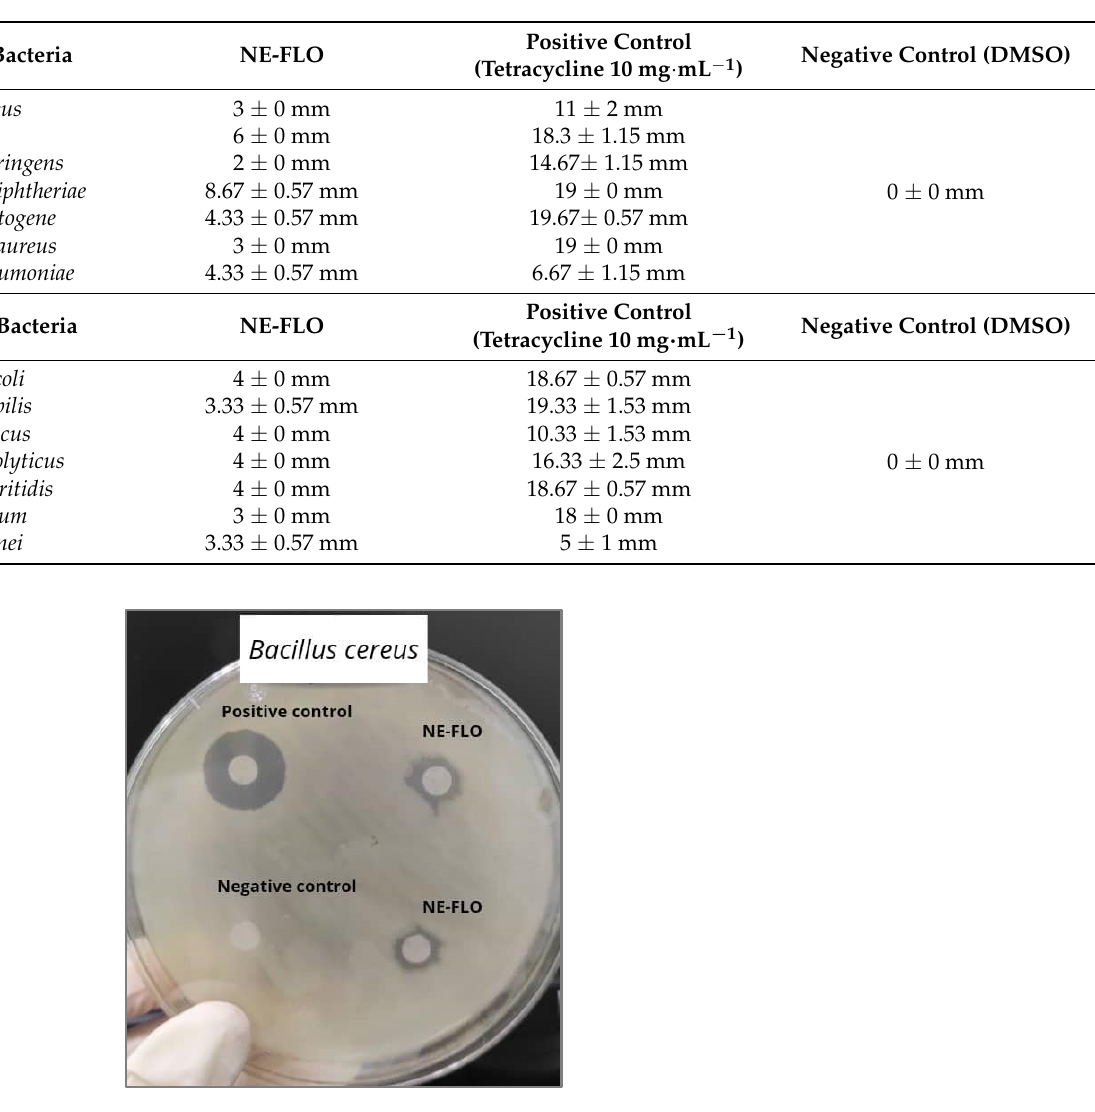
Table 4. Antimicrobial activity of NE-FLO and controls against different bacterial strains by disc diffusion method.